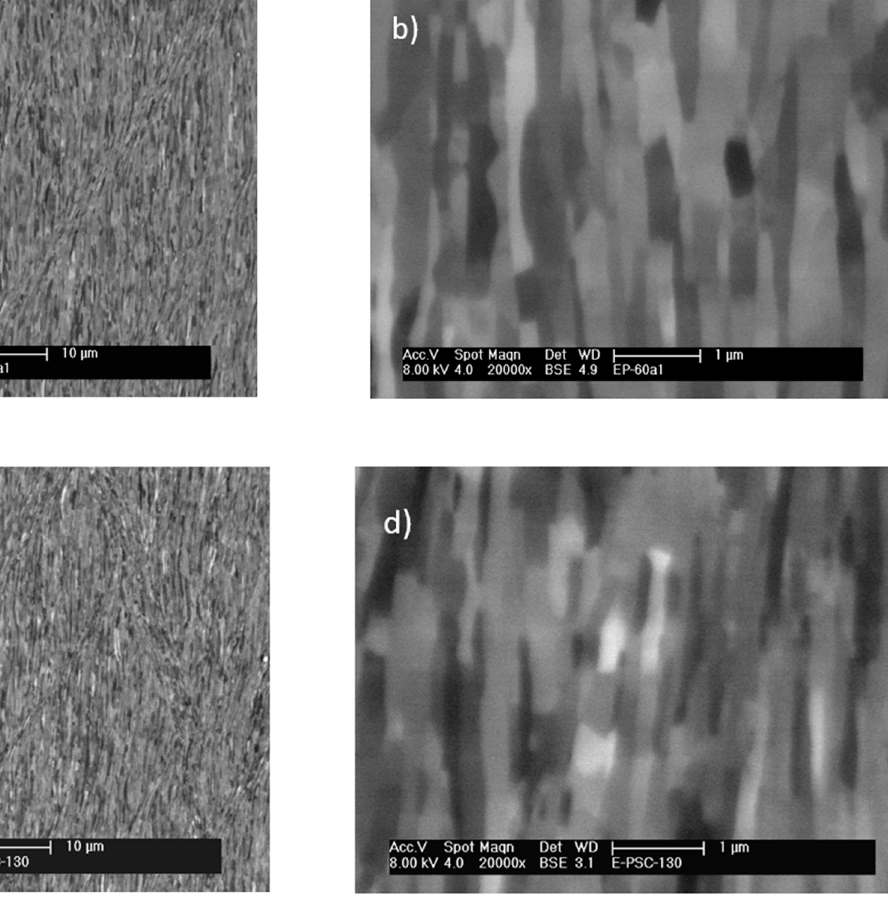
Figure 3. EBS images showing the microstructures on the TD plane obtained after PSC to a true strain of 2.1 at 215 K ( a , b ), 130 K ( c , d ) and 77 K ( e , f ). The compression direction is horizontal. This trend in shear band alignment is similar to that found in PSC and rolling at more conventional strains [22], although the intensity of shear banding lessened with decreas- ing temperature and they reduced in width, until they completely vanished at 77 K.